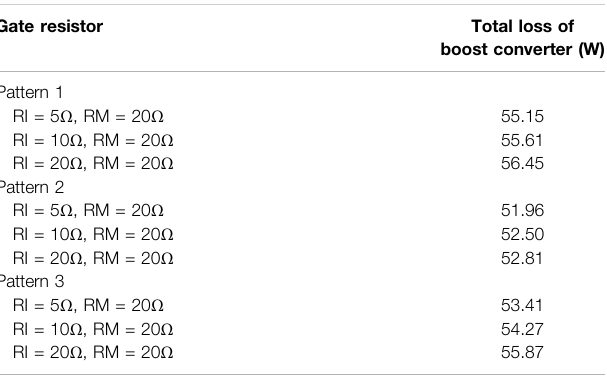
TABLE4| Relationshipbetweenthegateresistorandtotallossofboostconverter (changing gate resistor of Si IGBT). Gate